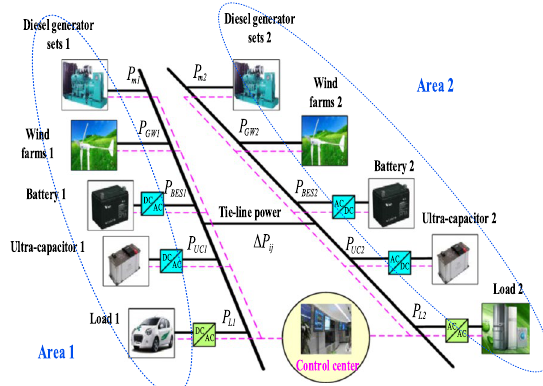
Fig. 1 Block diagram of wind-diesel micro-grid